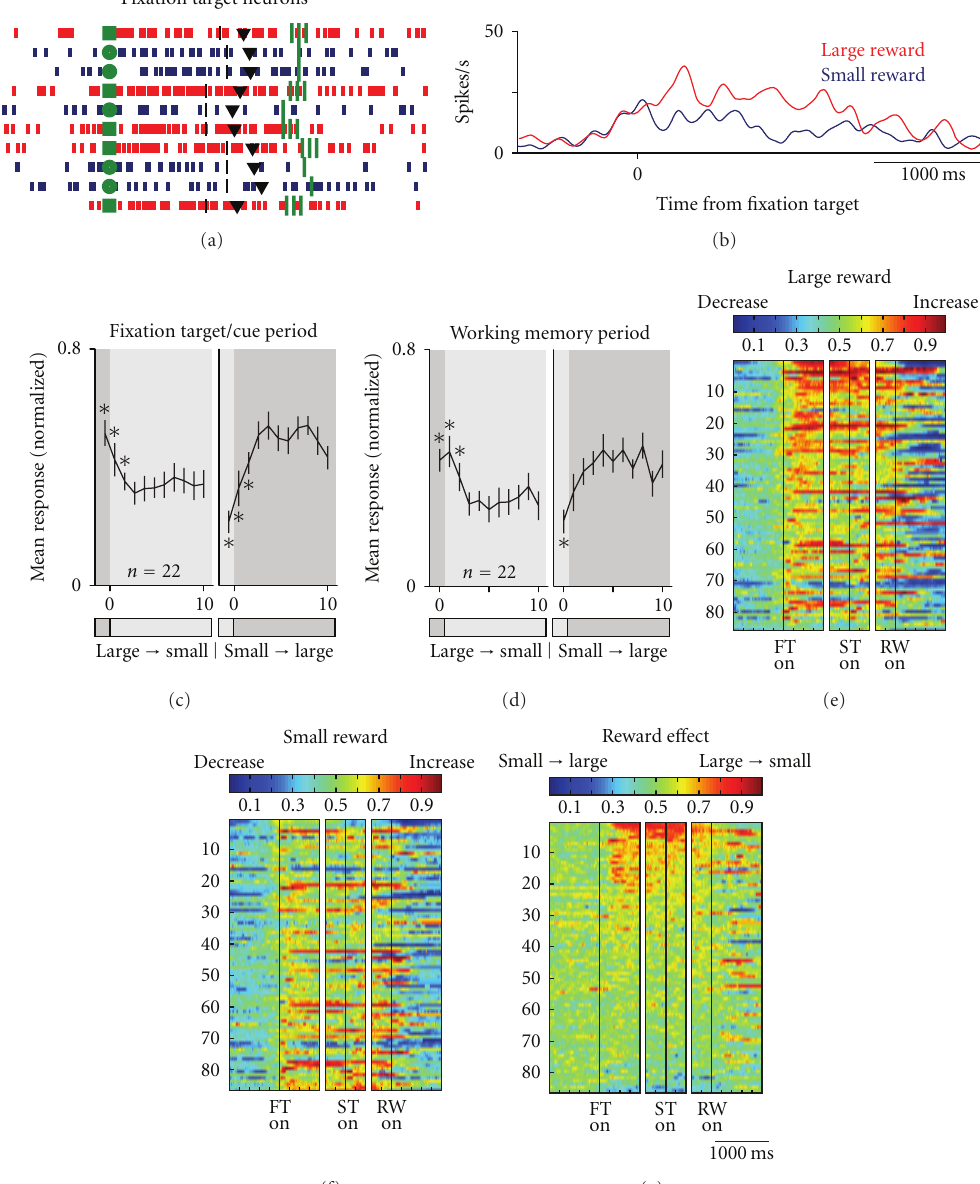
Figure 3: Activity of fixation target neurons of the PPTN for the saccade task. (a, b) A rastergram and peritask event spike density function for the activity of a representative fixation target neuron over 10 successive trials, aligned to the onset of the fixation target. The red and blue rasters (a) and traces (b) indicate large and small reward trials, respectively. In (a), the green squares and circles indicate fixation target onset, the blackbars indicate the onset of the saccade target, the black triangles indicate saccade onset, and the green lines indicate the times at which the large (3 bars) and small (1 bar) rewards were delivered. (c) Responses of fixation target neurons to fixation target (squares and circles) presentation (mean response of 200–600ms after fixation target onset, fixation target/cue period) after reversal of cue-reward contingency. The left panel shows the large-to-small reward reversal, and the right panel shows the small-to-large reward reversal. Large-reward trials are indicated by the dark gray bars, while small-reward trials are indicated by the clear areas. Shown are the mean and standard error of the mean (SEM) of the normalized neuronal activity for the n th trial after contingency reversal. The asterisks ( ∗ ) indicate the activity that was significantly di ff erent from the activity during the last 5 trials of the block with the reversed contingency ( P < 0 . 01, Mann-Whitney U test). (d) Similarto (c) but for the responses after fixation target o ff set (working memory period, 200–600ms after fixation target o ff set). (e–g) The activity of each fixation responsive neuron is presented as a row of pixels ( n = 86). (e, f) Changes in the neuronal firing rate from baseline are compared in the large- (e) and small- (f) reward trials. The color of each pixel indicates the ROC value based on the comparison of the firing rate between a control period just before fixation onset (400-ms duration) and a test window centered on the pixel (100-ms duration). Warm colors (ROC > 0.5) indicate increases in the firing rate relative to the control period, whereas cool colors (ROC < 0.5) indicate decreases in the firing rate. (g) Changes in reward-dependent modulation. The ROC value of each pixel was based on the comparison of the firing rate between the large- and small-reward trials. Warm colors (ROC > 0.5) indicate higher firing rates in the large-reward trials than in the small ones. In these 3 panels (e–g), the neurons have been sorted in order of their ROC values for the reward prediction e ff ect during the task period. FTon: fixation target onset; STon: saccade target onset; RWon: reward onset. (Modified from